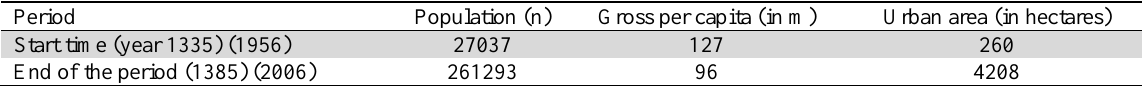
The summary of basic statistics associated with Heldern method Period Population (n) Gross per capita (in m) Urban area (in hectares) Start time (year 1335) (1956) 27037 127 260 End of the period (1385) (2006) 261293 96 4208 Using Eq. (2) and Eq. (3)